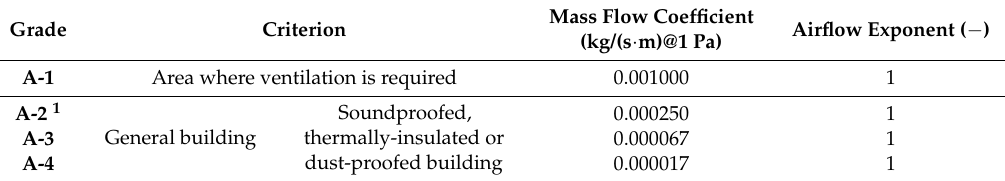
Table 11. Airtightness of windows based on the Japanese Industrial Standard